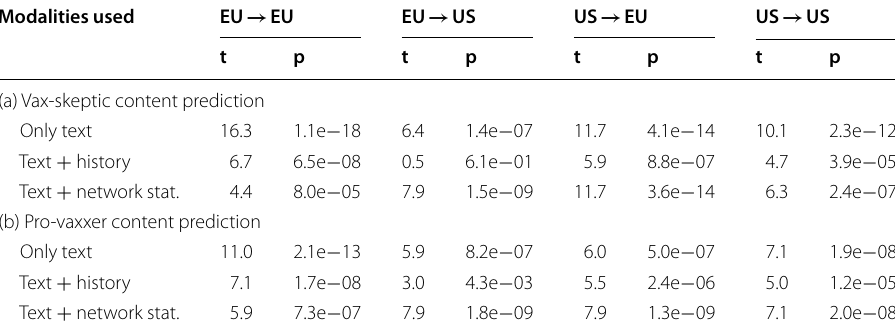
Table 6 Cross-region model evaluation for pro-vaxxer content prediction with respect to different modalities